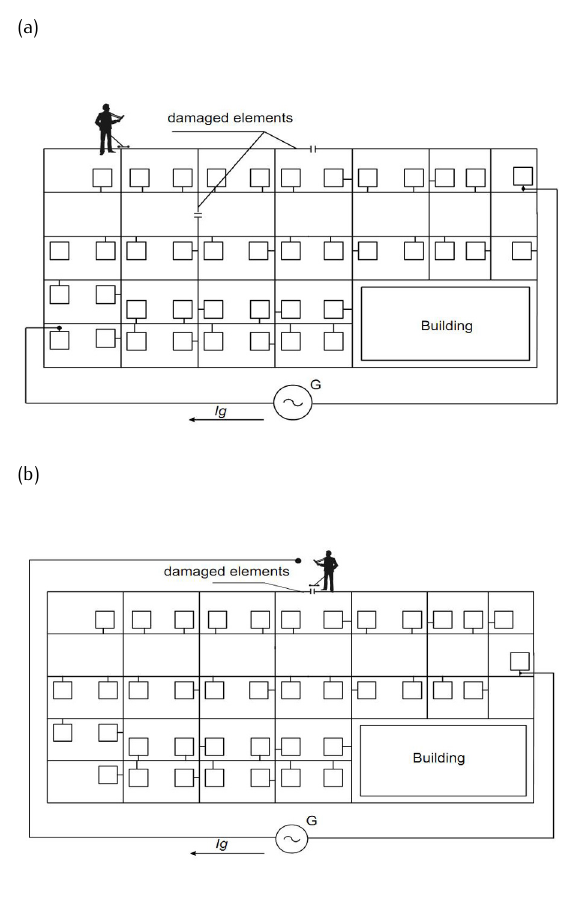
Figure 5. Grounding Device Investigation (a) Step 1, (b) Step